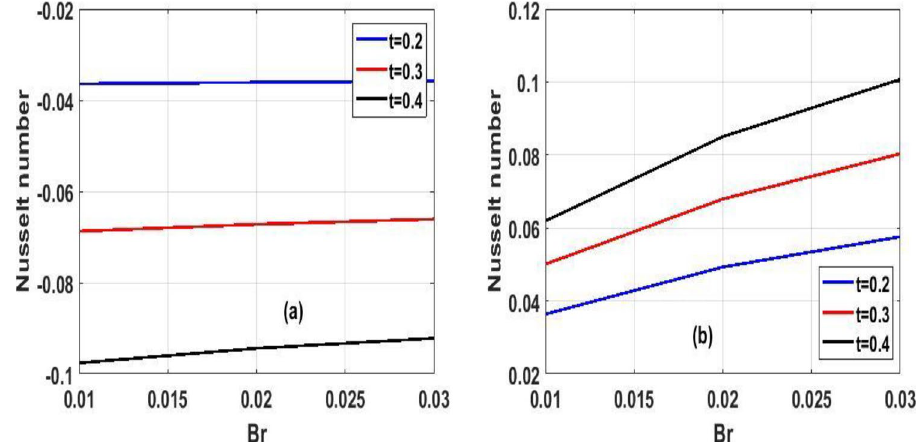
Figure 13. Unsteady Nusselt number for ( (cid:31) ) in proportion to ( t ) .